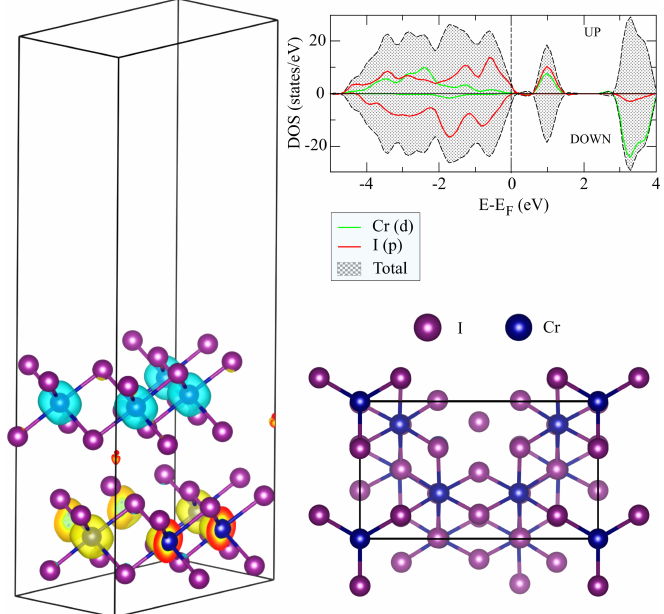
Figure 3. Orthorhombic unit cell used for simulating two CrI 3 layers coupled antiferromganetically and isosurface of the magnetization density (light green for spin-up and yellow for spin-down channels correspondingly). The top view of the unit cell. Computed total and partial density of